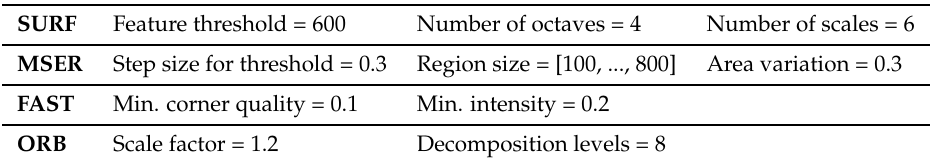
Table 1. Parameters for Speeded Up Robust Feature (SURF), Maximal Stable Extremal Region (MSER), Features from Accelerated Segment Test (FAST), and Oriented FAST and Rotated BRIEF (ORB) feature detectors.